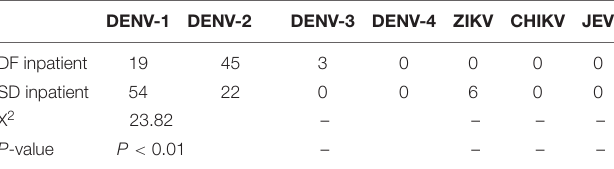
TABLE 2 | Mosquito-borne virus (DENV 1-4, ZIKV, CHIKV, JEV) or virus coinfection identification. DENV-1 DENV-2